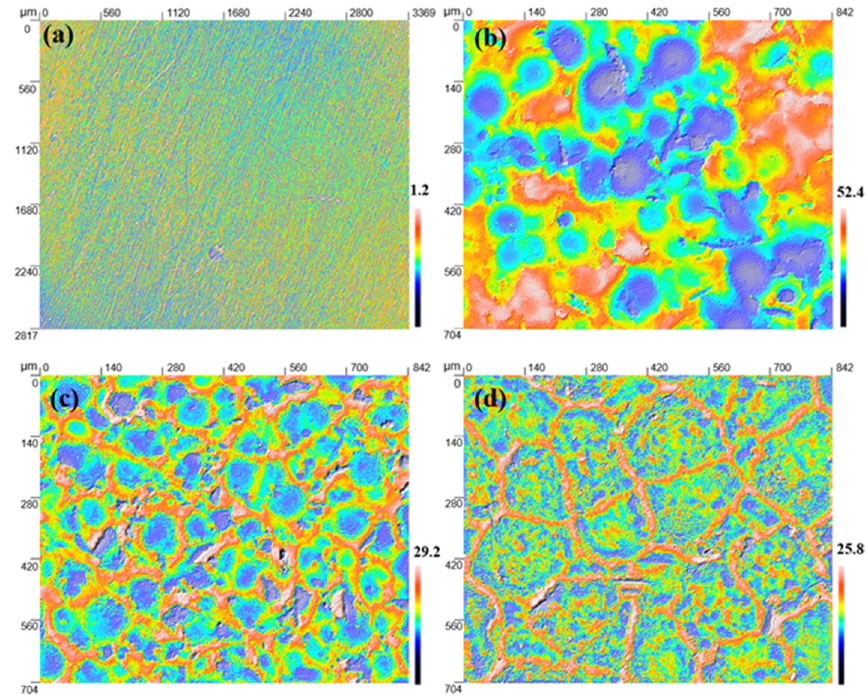
Figure 2. Surface topography of the specimen untreated by peening process ( a ), and after ( b ) 0.25 mmA ( c ) 0.25 + 0.15 mmA, ( d ) 0.25 + 0.15 + 0.05 mmA peening treatment.